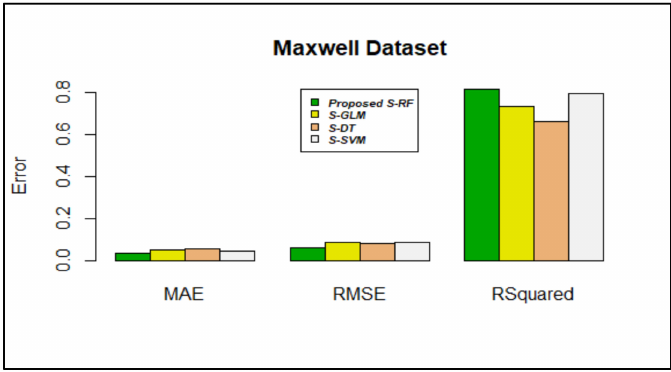
Figure 7. Error rate vs. stacking models in the Maxwell dataset.